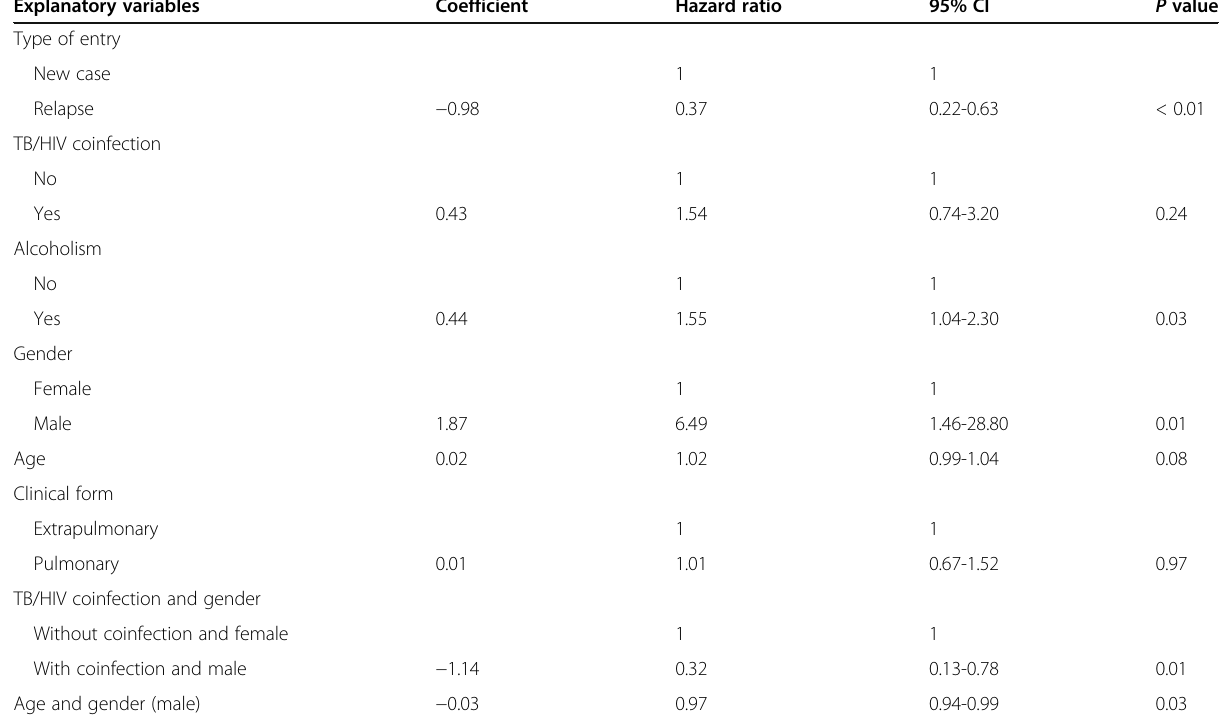
Table 4 Results of the Cox proportional hazards regression model of patients who died from TB and associated factors, Curitiba-